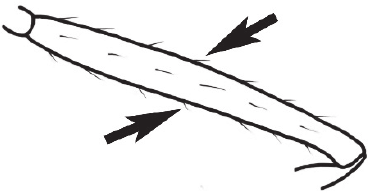
more commonly several individual setae) .................................................. 70